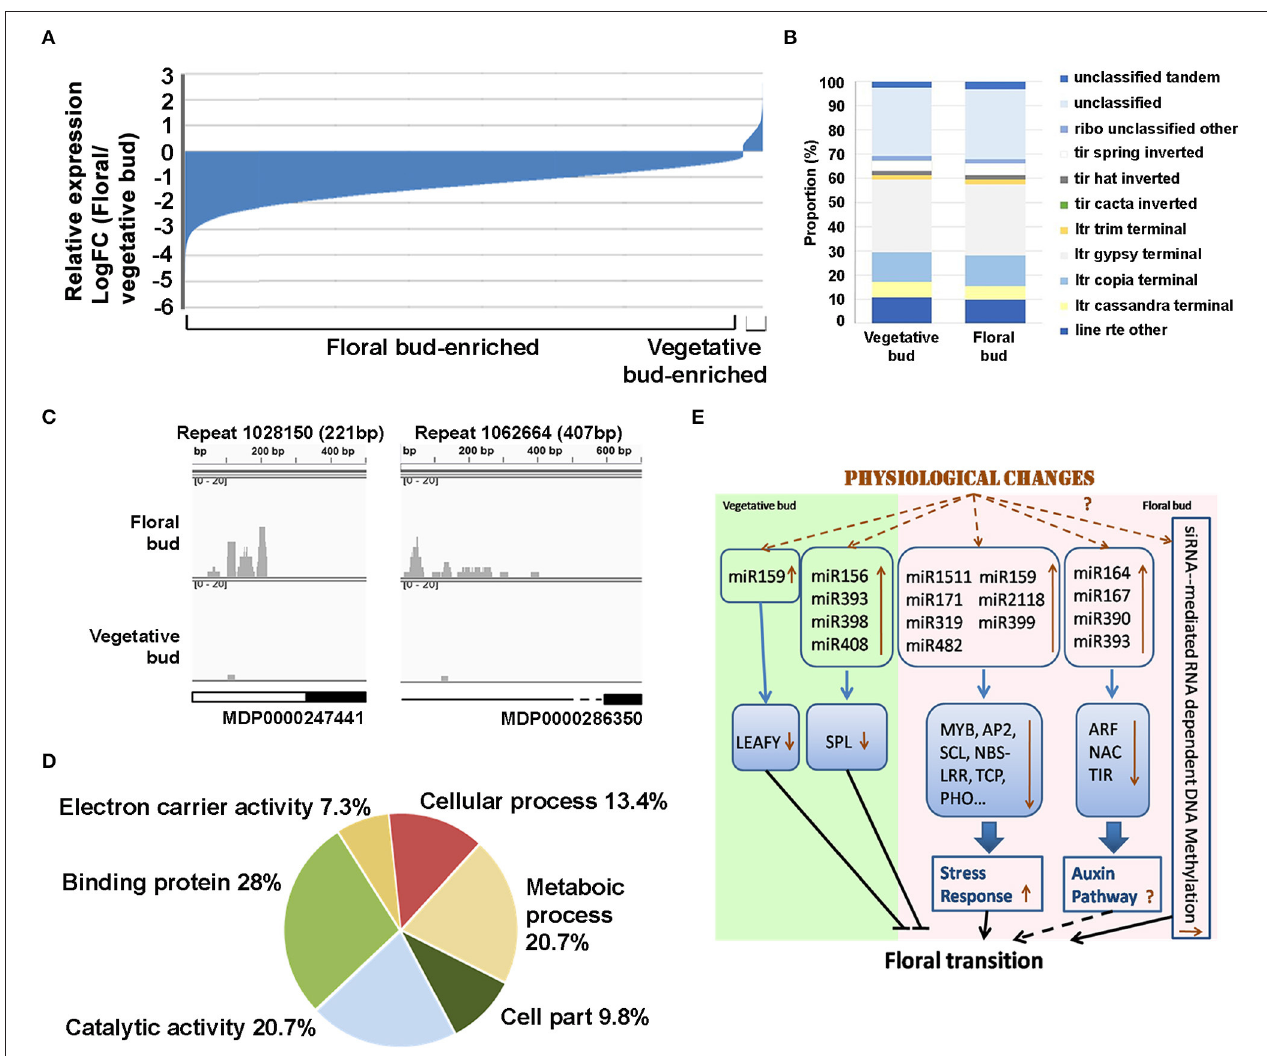
FIGURE 4 | Differentially expressed 24 nt-siRNA during floral transition of Malus domestica. (A) Expression pattern of all differentially expressed siRNAs (DE-siRNAs) between vegetative and floral buds. Expression level was given as Log 2 Fold Change (FC, floral bud/vegetative bud). (B) Classification of all DE-siRNA genomic distribution. (C) IGV analysis of some top 50 DE-siRNAs. White box indicated intron, black box indicated extron and black line indicated intergenic region. Black imaginary line indicated the briefly long distance of intergenic region. (D) GO analysis of targeted loci by top 40 DE-siRNAs. (E) Potential model of sRNA-mediated floral transition in Malus domestica . Arrows indicated up-regulation or down-regulation. Dot line and “?” indicated unconfirmed interaction or